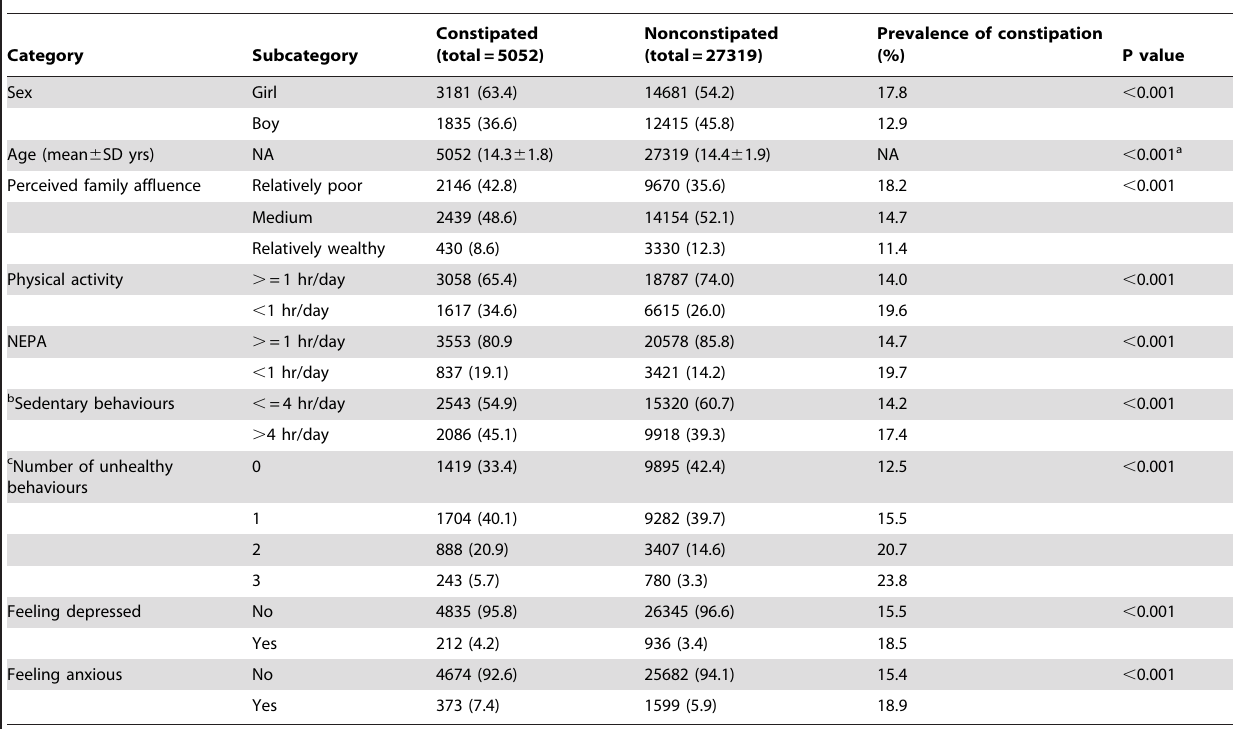
Table 1. Background information of subjects with constipation and without constipation (N= 32371).